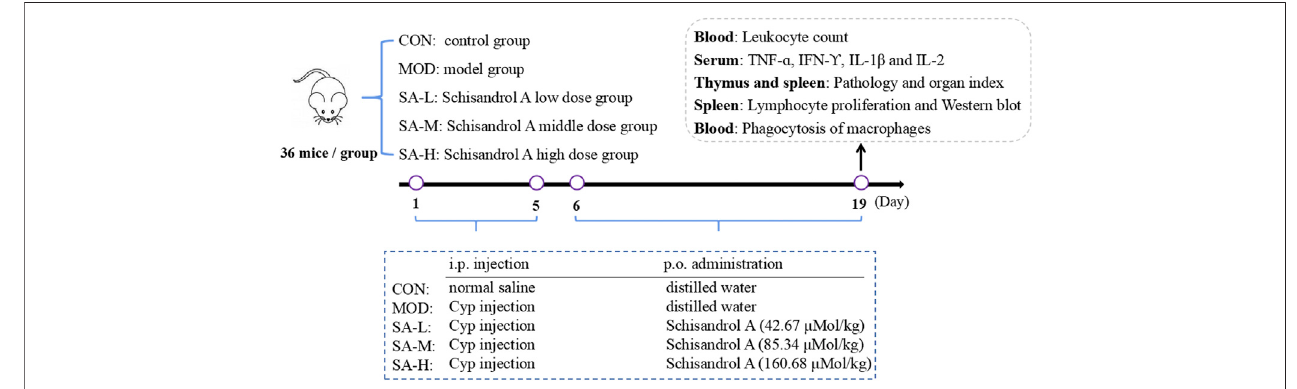
FIGURE 1 | Experimental